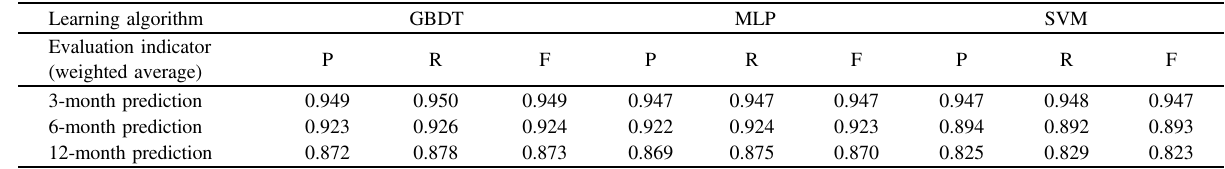
Table 6 Future eligibility level prediction based on multiclass classi fi cation and three di ff erent learning algorithms. Learning